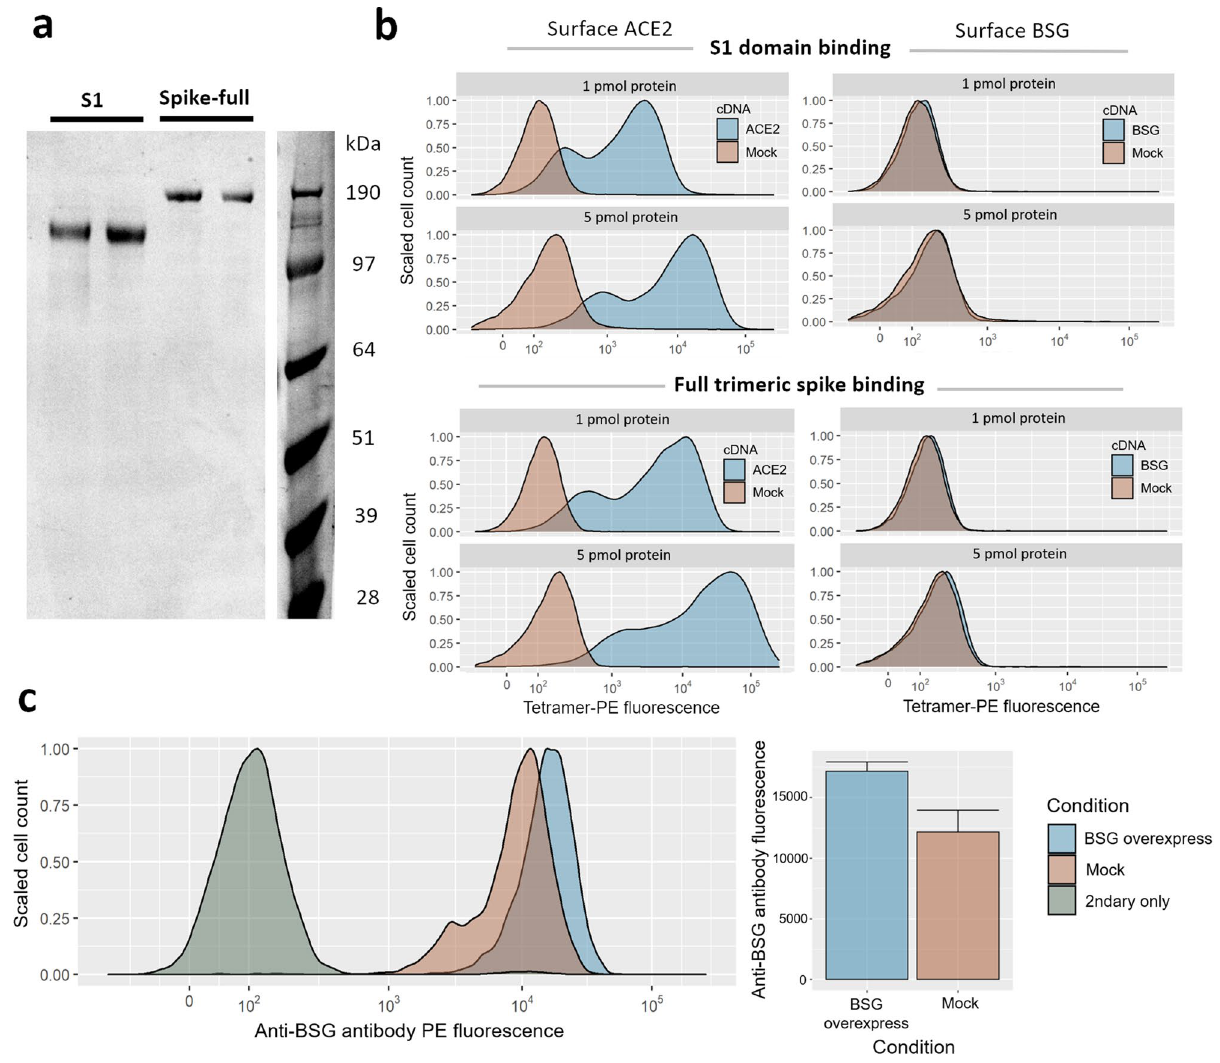
Figure 1. Gain of SARS-CoV-2 spike binding activity on human cells over-expressing ACE2 but not BSG . ( a ) Expression and purification of the S1 domain and full ectodomain of the SARS-CoV-2 spike protein produced in human cell lines. Two independent preparations of purified spike were resolved by SDS-PAGE under reducing conditions and stained with Coomassie blue dye. ( b ) Cells transfected with cDNAs encoding ACE2 but not BSG bind highly avid fluorescent SARS-CoV-2 spike tetramers . Flow cytometry fluorescence distributions of cells stained with tetramers composed of biotinylated spike protein either using the S1 domain (top panels) or the entire ectodomain (lower panels) clustered around phycoerythrin-conjugated streptavidin. The stained HEK293 cells were transfected with cDNA to overexpress either ACE2 (left) or BSG (right). Mock-transfected cells are shown in red. Similar behavior to the data shown was observed in three separate tests. ( c ) Transfection with BSG cDNA leads to upregulation of cell-surface BSG. Surface basigin levels on HEK293 cells labeled with an anti-human BSG monoclonal antibody. BSG levels are compared to a negative control of secondary-antibody only. Mean antibody fluorescence intensities are summarized in the adjacent bar graph, with error bars showing standard deviations (n =